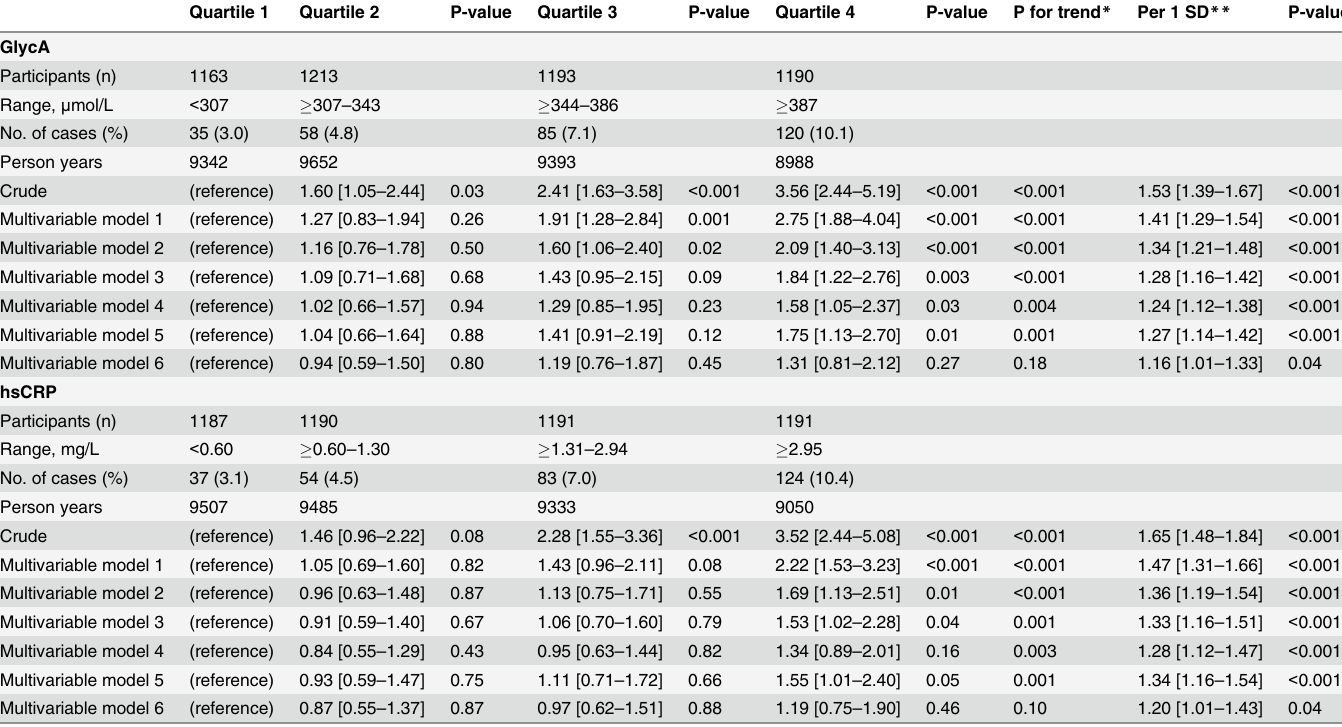
Table 3. Association between GlycA and hsCRP levels and cardiovascular event in 4,759 participants (298 events) of the PREVEND